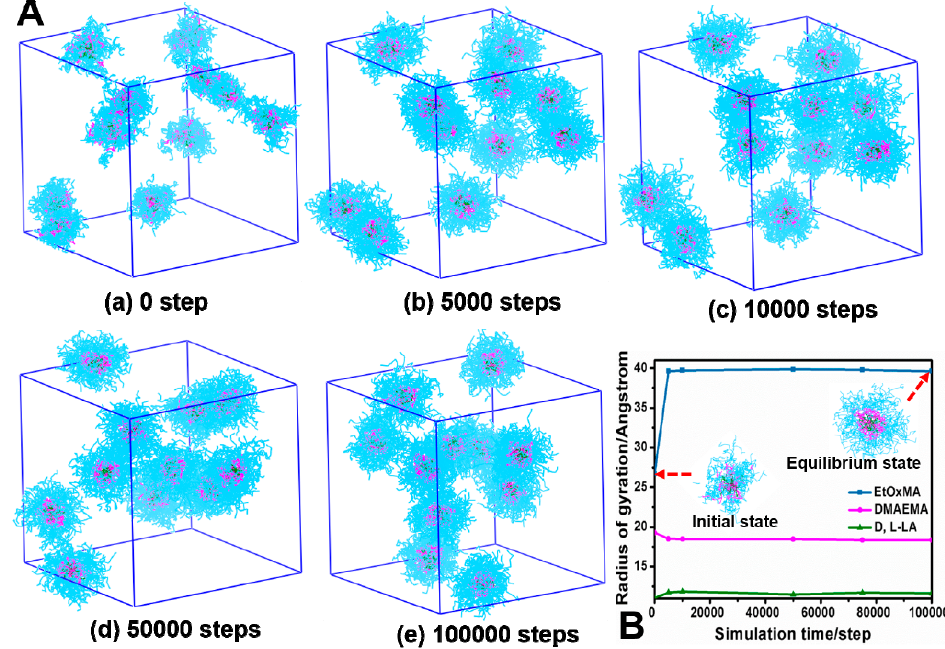
Figure 4. DPD simulation of β -CD-(PLA- b -PDMAEMA- b -PEtOxMA) 21 at different simulation times at experimental concentration of 0.1 mg/mL. ( A ) Formation process. ( B ) Radius of gyration of EtOxMA, DMAEMA, and D , L -LA.